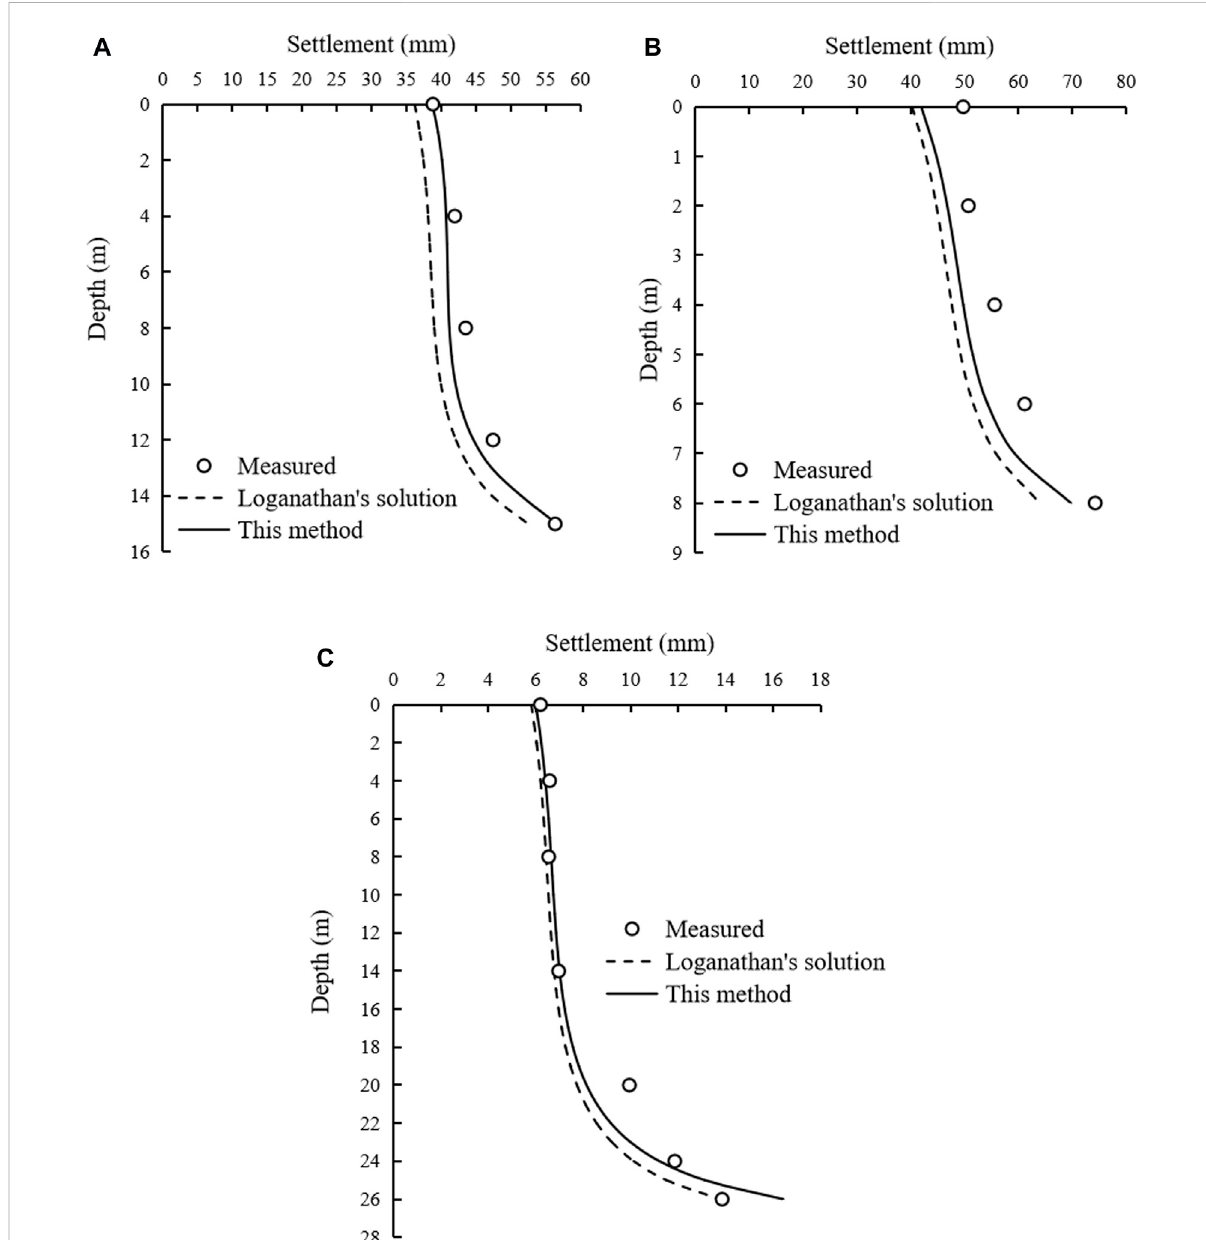
FIGURE 7 Settlementabovethetunnelcenterinducedbygeneralcirculartunneling: (A) HeathrowExpressTrailTunnel; (B) ThunderBayTunnel; (C) Green Park